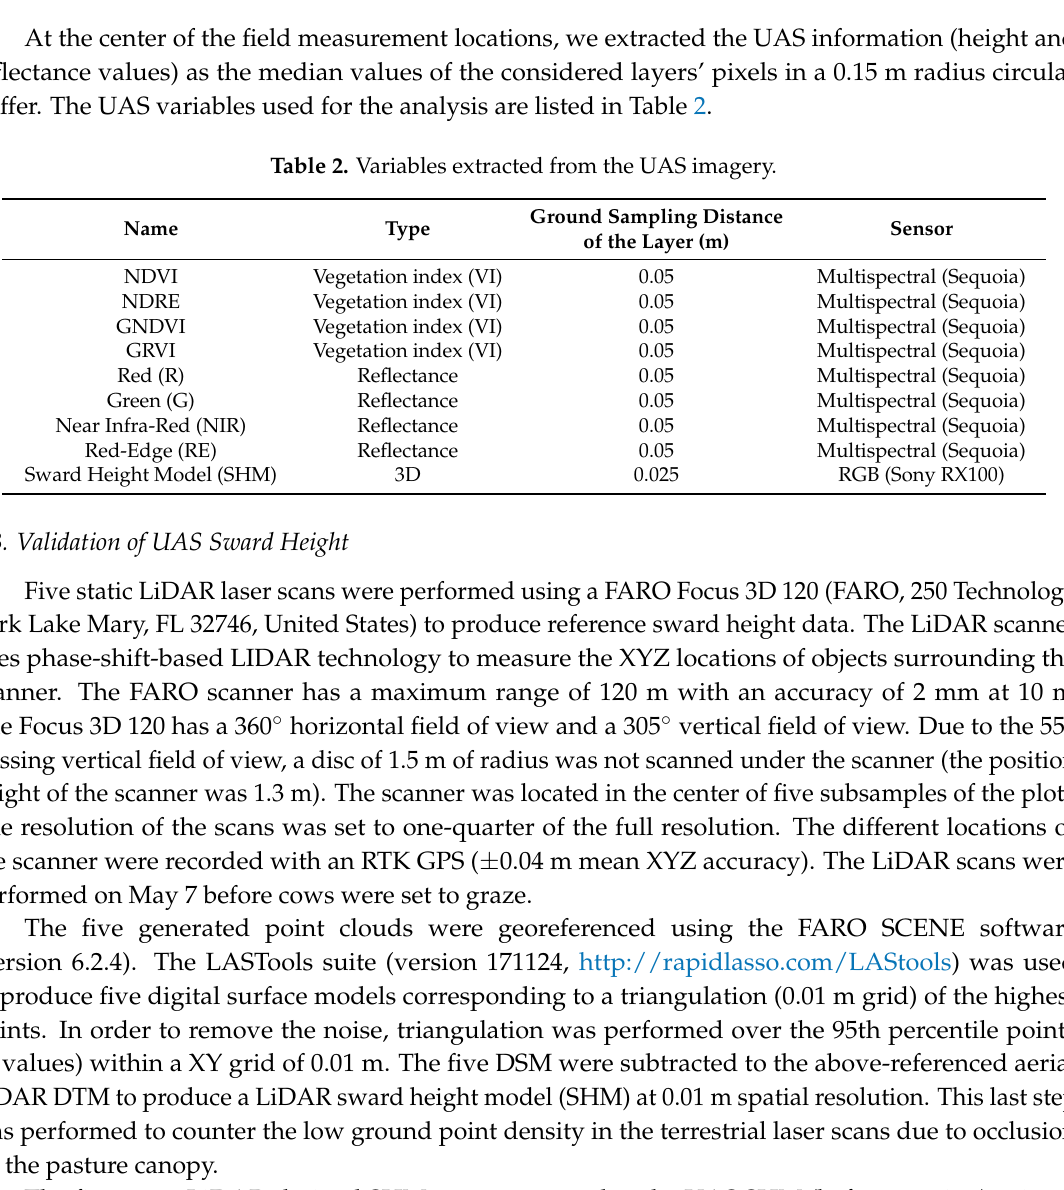
Table 1. Vegetation indices computed from the reflectance layers provided by the multispectral camera. Vegetation Index Formula Parameter Reference Photosynthetic activity, Normalized Difference Vegetation [35] (NIR − RED)/(NIR + RED) plant stress Index (NDVI) Normalized Difference Red (NIR − REDEDGE)/(NIR + REDEDGE) [36] Edge (NDRE) More sensitive to Green NDVI (GNDVI) chlorophyll-a concentration, [37] Green Ratio Vegetation Index (GRVI) Photosynthetic activity